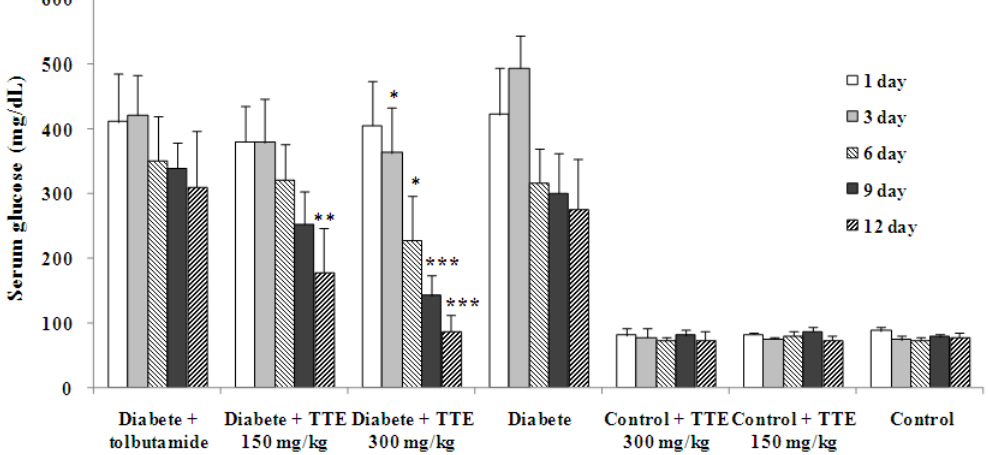
Figure 1. Effects of CMPE on fasting blood glucose levels in normal and STZ-induced diabetic rats. (Means ± SEM, n = 6). * p < 0.05, ** p < 0.01, *** p < 0.001, compared to diabetic rats on the same